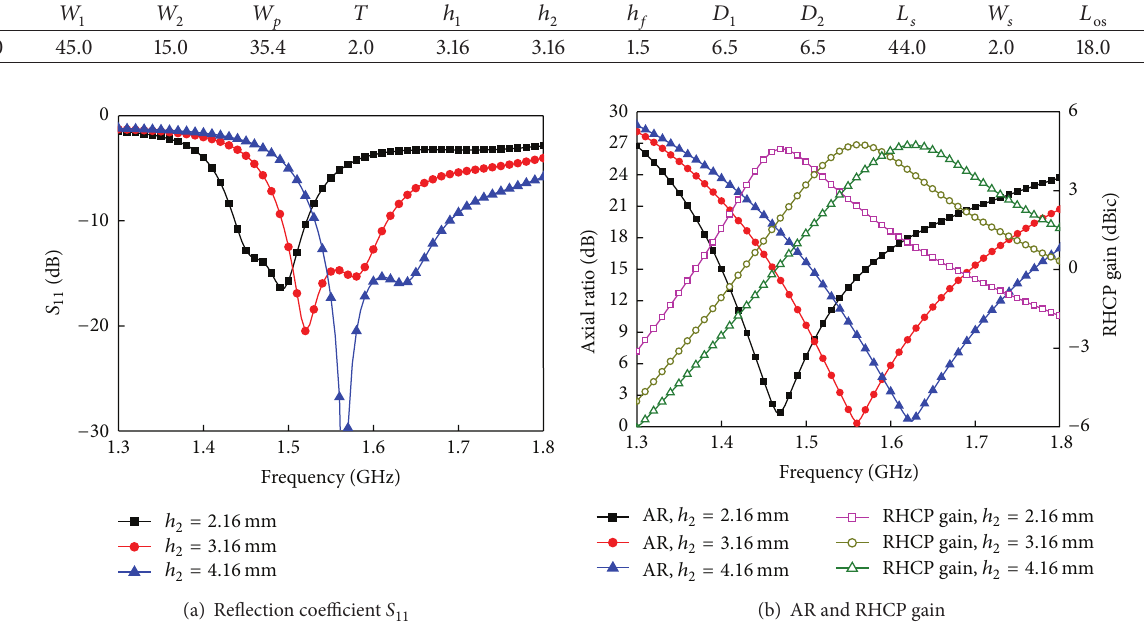
is connected to an SMA launcher that is mounted on the wall of the